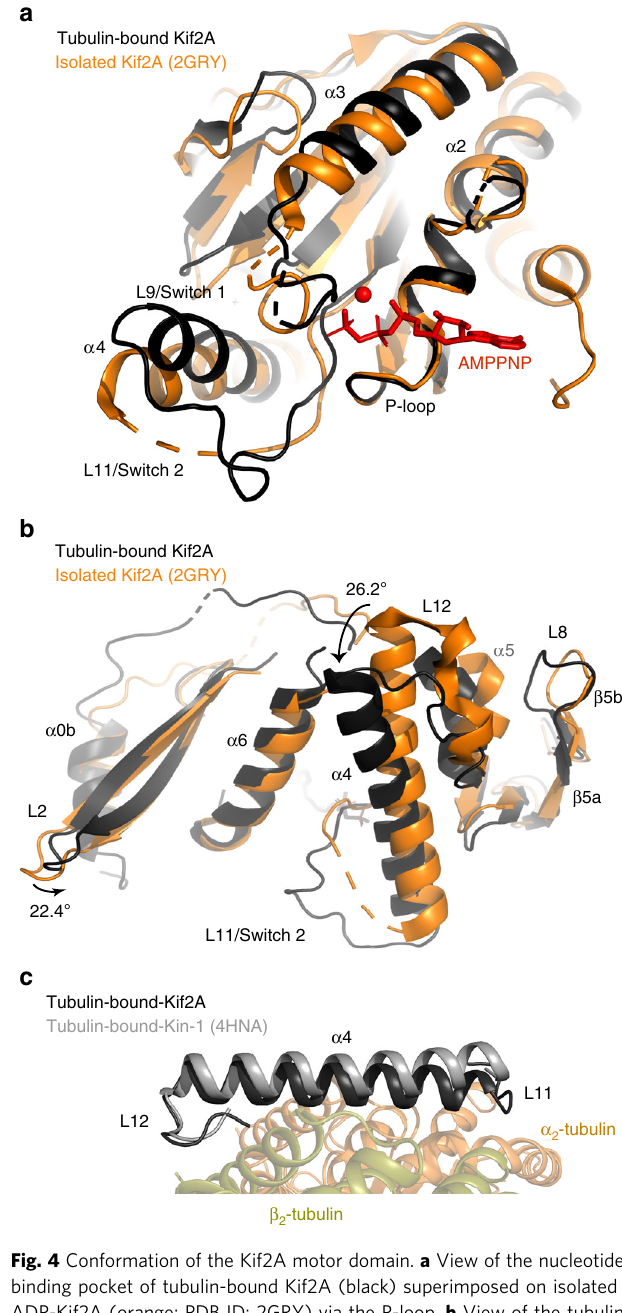
Fig. 4c. These fi ndings argue against postulations that a more curved tubulin interface on the kinesin-13 motor domain explains their MT depolymerization capability 12,21 . Although the recent mouse Kif2C core:ADP-AlF x and Kif2C core:ADP-BeF x struc- tures (PDB ID: 5XJA and 5XJB, respectively) were used to sup- port this hypothesis and are presented as the “ activated ” conformation that sustains the Kif2-tubulin 1:2 complex 34 , the tubulin-binding elements of these structures (L8, β 5a – β 5b β - sheet, L11, L12, α 4, α 5, and α 6) superimpose poorly with those of Kif2A-NM (Supplementary Figure 4).